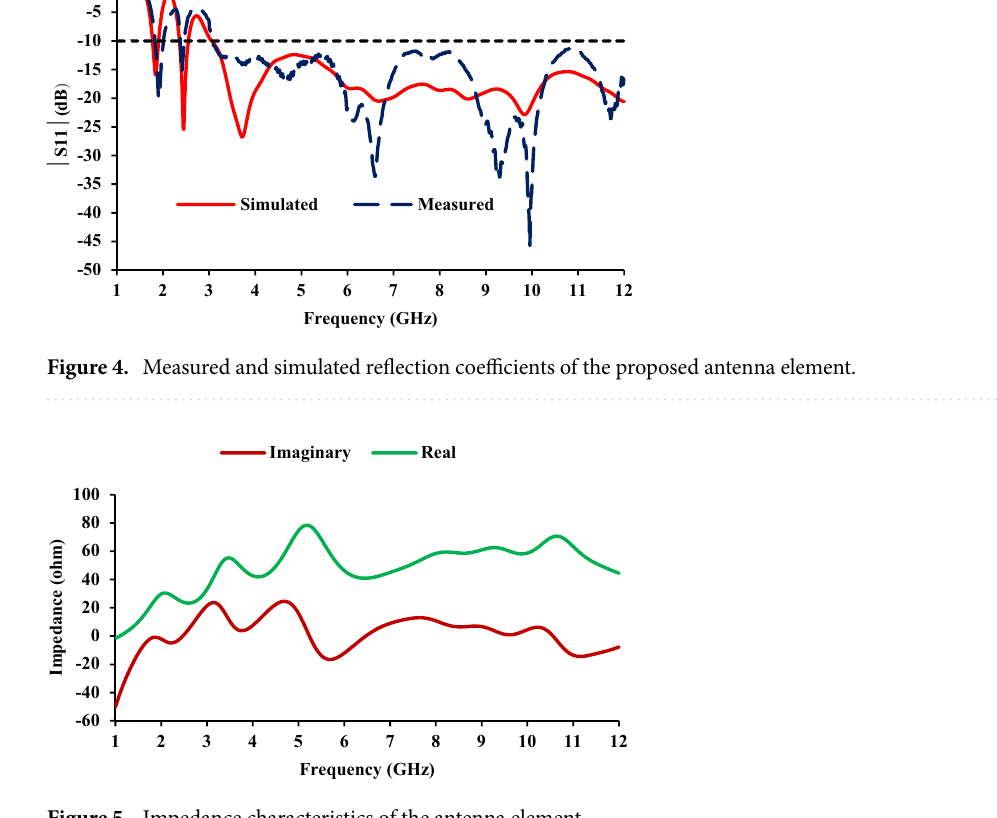
Fig. 5. The two maximum impedance points (3.83 GHz and 9.86 GHz) are selected from the reflection coefficient characteristics, and the corresponding circuit for UWB is derived. When the impedance curve moves from low (negative) to high (positive), a series resonant circuit is drawn, and when the curve moves from high (positive) to low (negative), a parallel resonant circuit is drawn 26 . The equivalent circuit of the antenna is shown in Fig. 6, and the corresponding RLC parameters are shown in Table 2. The two parallel resonant circuits correspond to 1.8 GHz and 2.4 GHz, respectively, and the two series resonant circuits correspond to UWB.